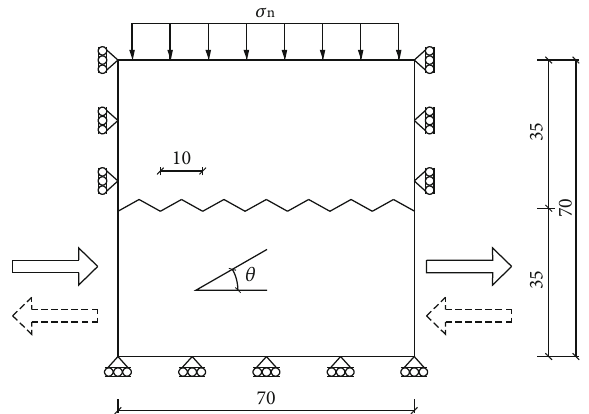
Figure 2: Sample loading process (units = mm).